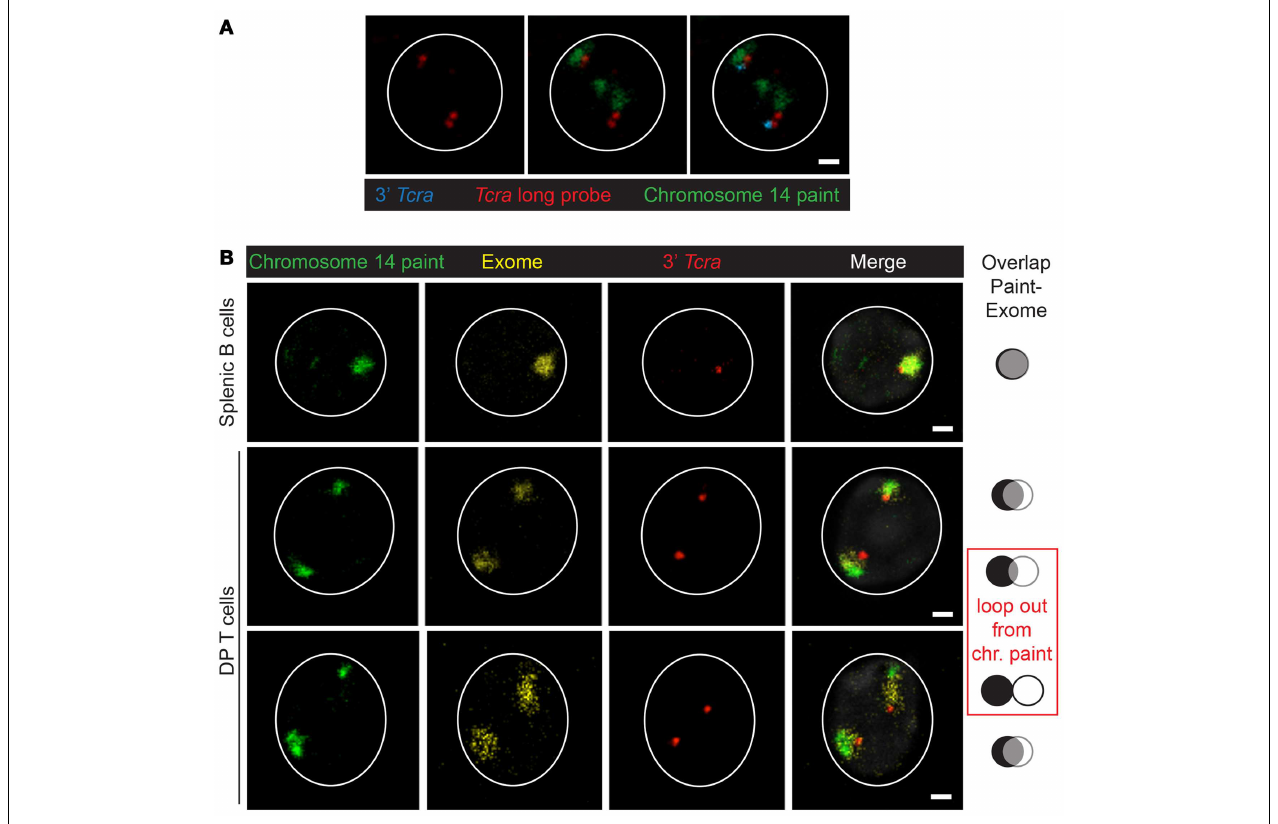
exome probe (gene-rich regions) in yellow and the 3 (cid:48) Tcra probe in red. The paint and exome domains overlap in splenic B cells and in DPT cells when Tcra is close to the paint domain and not looped out, while the two signals are more separated when Tcra is looped out from the paint. In either case Tcra is never looped out from the exome domain. Scale bar = 1 µ